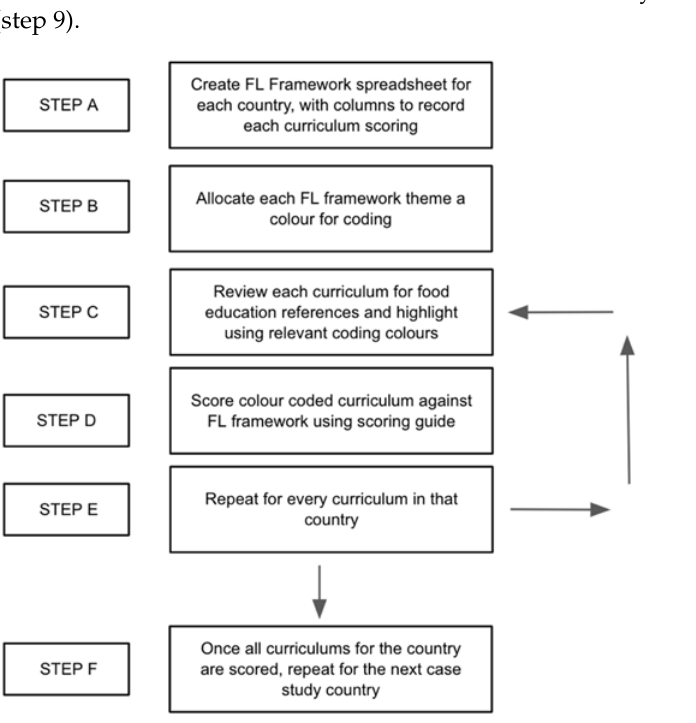
Figure 3. Curriculum content analysis process steps. Source: authors.